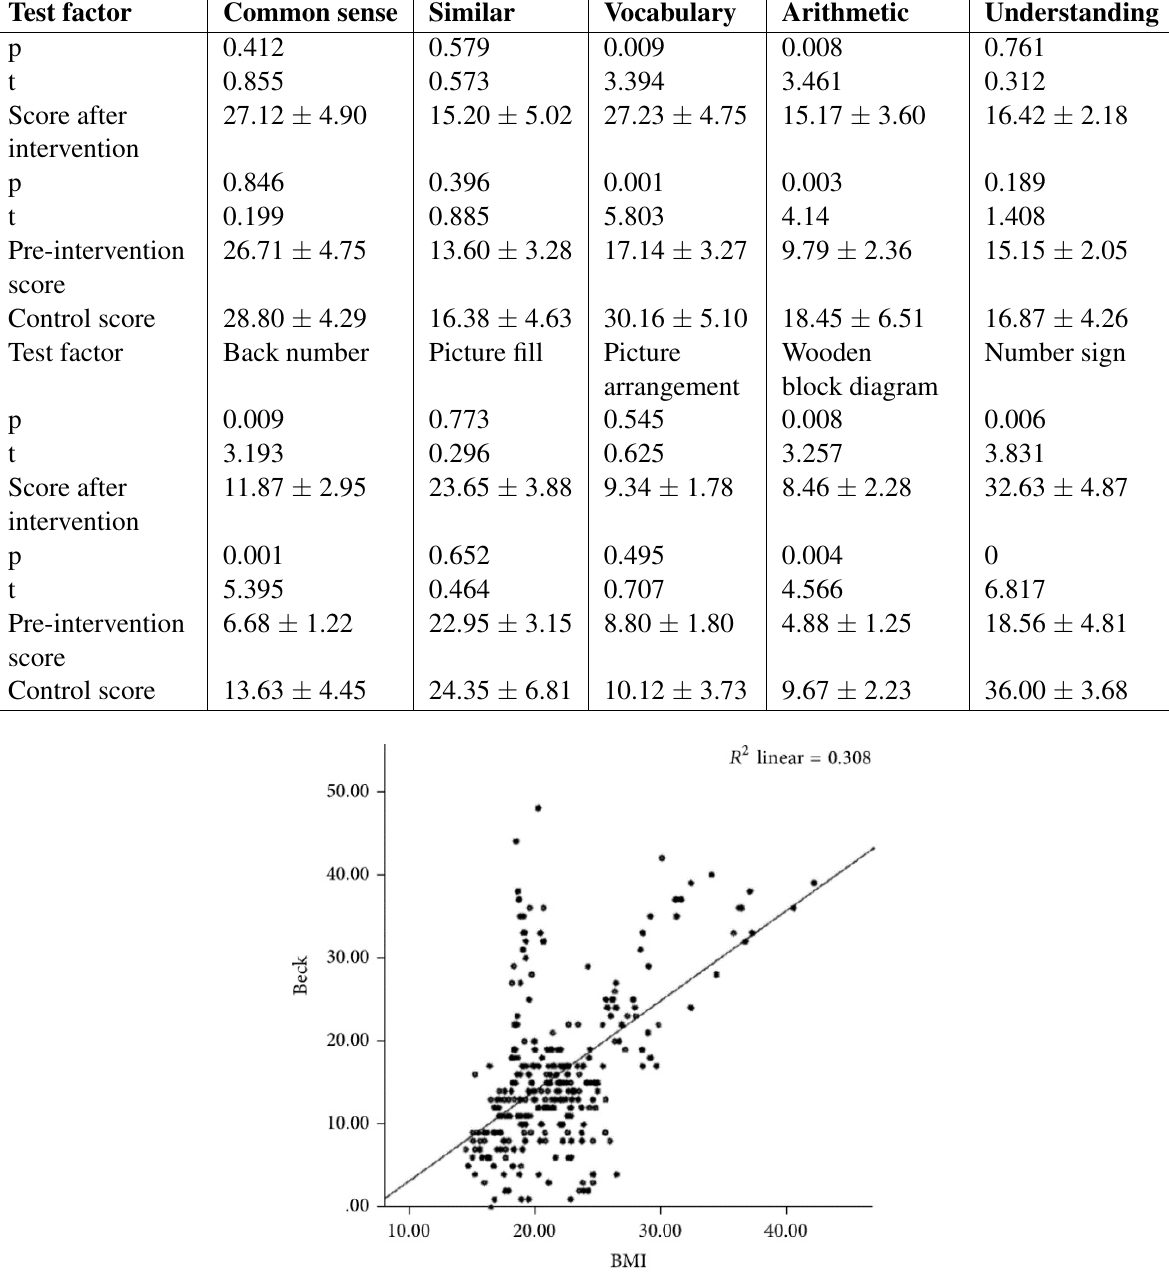
Table 4 Comparison of cognitive function test scores of obese children after aerobic exercise intervention.